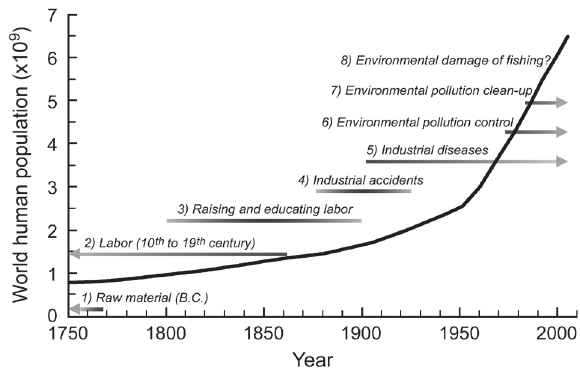
Fig . 2. – internalisation of so-called ‘external costs’ in the history of Western countries (adapted with modifications from Table 4, p. 81 in Hardin, 1972, with human population growth superimposed): (1) raw materials, internalised well before the Common era (C.e.); (2) labour, with invention of the horse collar in 1000 C.e., leading to a decline of slavery, finally abolished in 1863 C.e.; (3) beginning and spread of free public education; (4) industrial accidents: develop- ment of probability theory and of insurance schemes; (5) industrial diseases: pollution control, culminating in the u.S. Clean air acts of 1963 and 1970, and the Clean Water act of 1977; (6) the Mon- treal Protocol on Substances That Deplete the Ozone layer in 1989; (7) the u.S. Superfund Programme (1980) to clean up previously uncontrolled hazardous waste sites; and (8) environmental damage due to fisheries, which is still to be